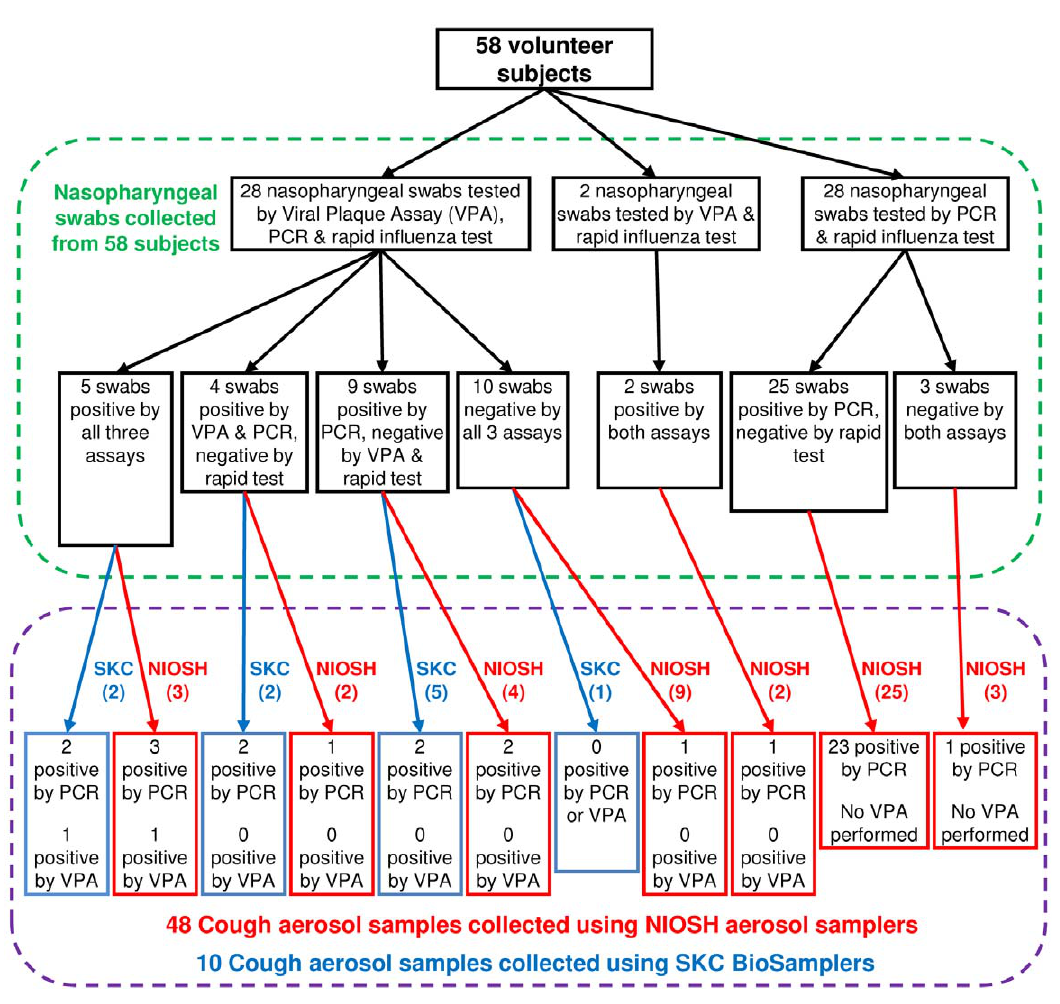
Figure 1. Flow chart showing patients and tests performed. The numbers in parentheses are the number of aerosol samples collected using SKC BioSamplers and NIOSH aerosol samplers.